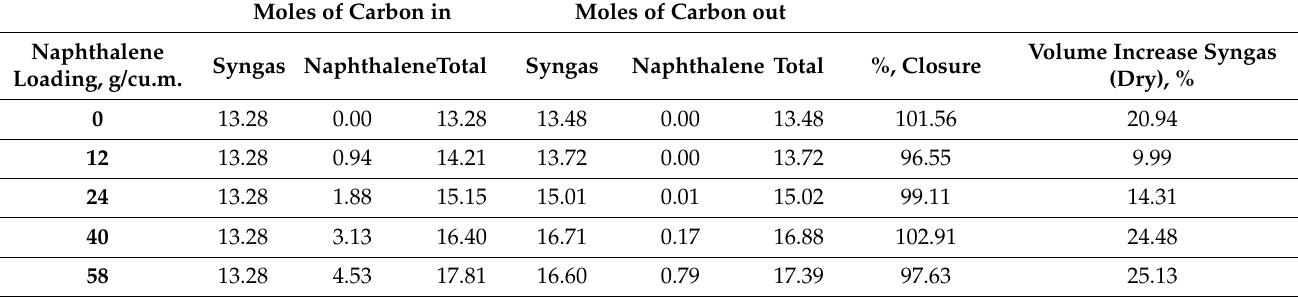
Table 6. Carbon balance: influence of naphthalene loading on its conversion (T—750 ◦ C, S/C—5, GHSV—12,800 h − 1 , catalyst—7.5% Ni-montmorillonite).